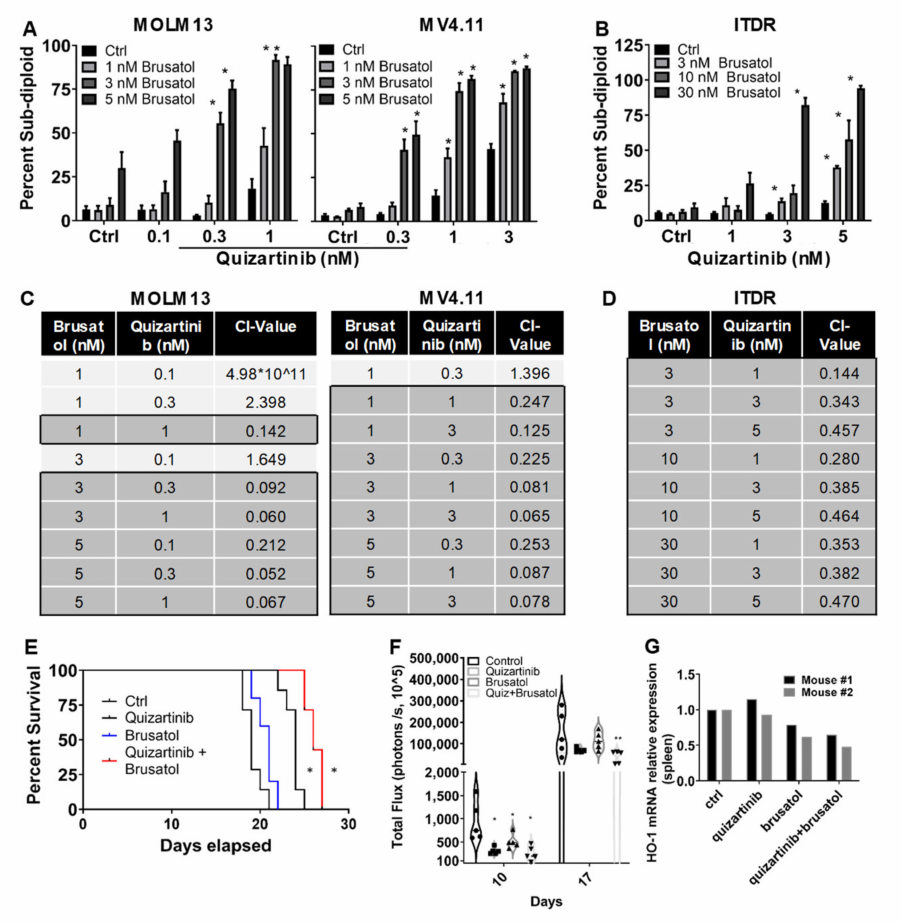
Figure 5. Brusatol potentiates quizartinib’s anti-leukemic effects in AML. ( A ) Bar diagram shows percentage of sub-diploid cells from the ratio of the mean DNA content of MOLM13 and MV4.11 human ITD-expressing cell lines and, ( B ) Ba/F3-Flt3-ITDR cell lines were treated with brusatol at the indicated concentrations and combined with quizartinib at the specified concentrations for 48 h. ( C ) Combination index values for combinations of the NRF2 inhibitor, brusatol, and FLT3 inhibitor, quizartinib, were measured in FLT3-ITD AML cell lines, MOLM13 and MV4.11. Synergy was determined based on DNA fragmentation assays using CalcuSyn software (Biosoft, Cambridge, United Kingdom), with combination index (CI) values < 1 considered synergistic, equal to 1 additive, and greater than 1 antagonistic. ( D ) Combination index values were obtained for the Ba/F3 Flt3- ITD-resitant cells treated with an inhibitor of NRF2 and an FLT3 inhibitor, quizartinib. ( E ) Prolonged survival upon combination of brusatol and quaizartinib in AML: overall survival of AML cell line xenograft-0derived AML-CDX. Briefly, 0.5 × 10 6 MOLM13 cells in 200 µ L of PBS were injected via the lateral tail vein in 250 Gy irradiated 5–6-week-old NSG-SGM3 mice ( n = 7 per group). Engraftment